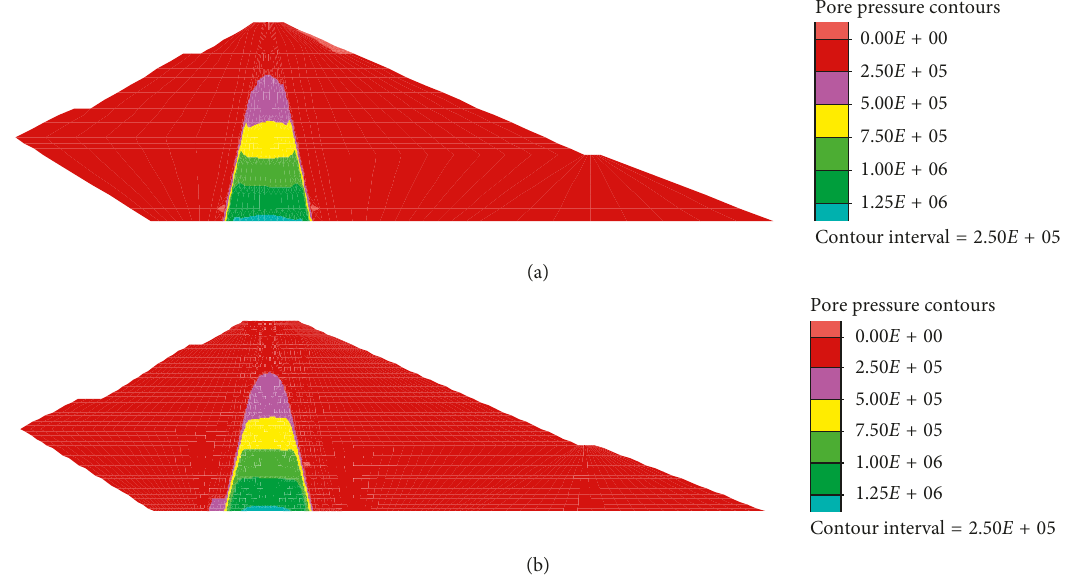
Figure 6: Pore water pressure ratio of the first and the second sample. (a) Coarse mesh size. (b) Fine mesh size.